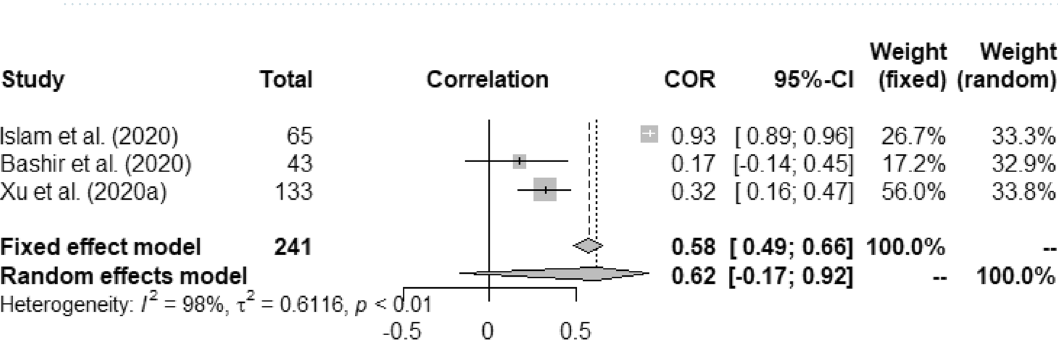
Figure 7. Forest plot of COVID-19 incidence with UV.